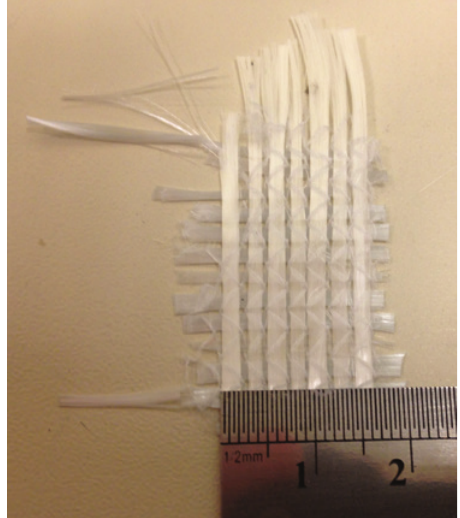
Figure 2: Fabric tow width ( ∼ 2